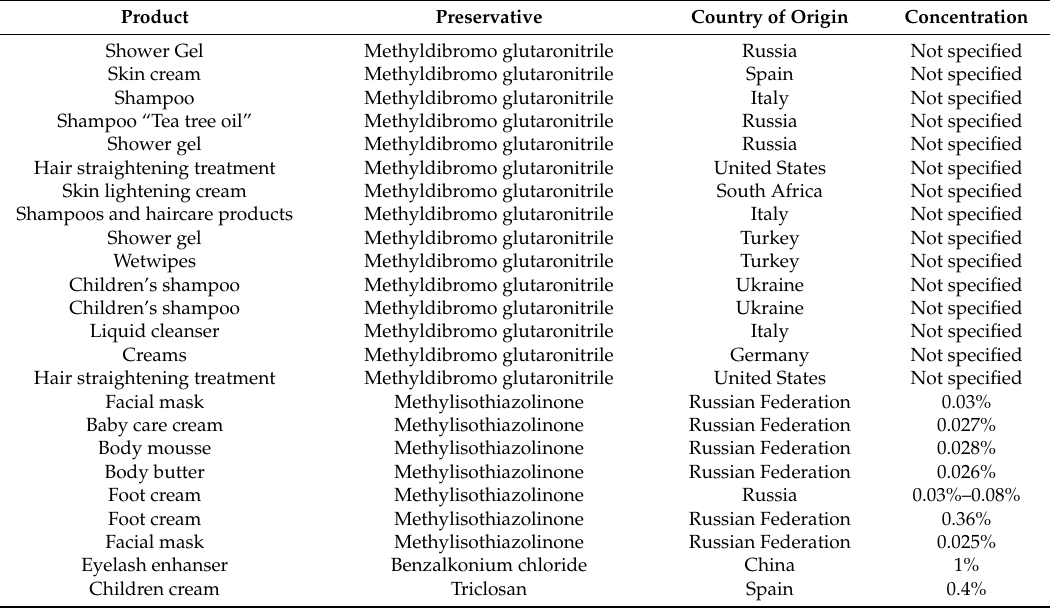
Table 2. Over-preserved